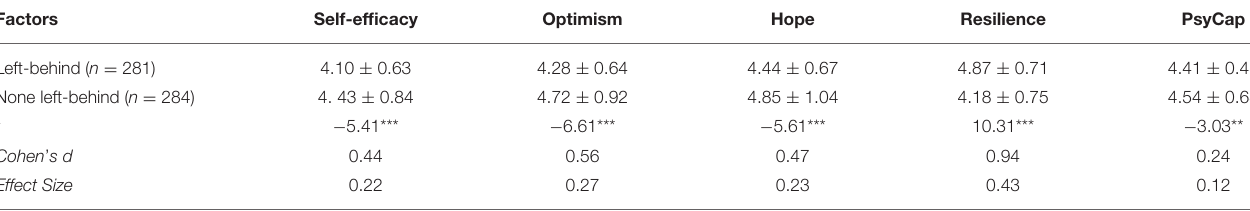
TABLE 1 | Comparison of psychological capital to the university students who were left-behind or not. Factors